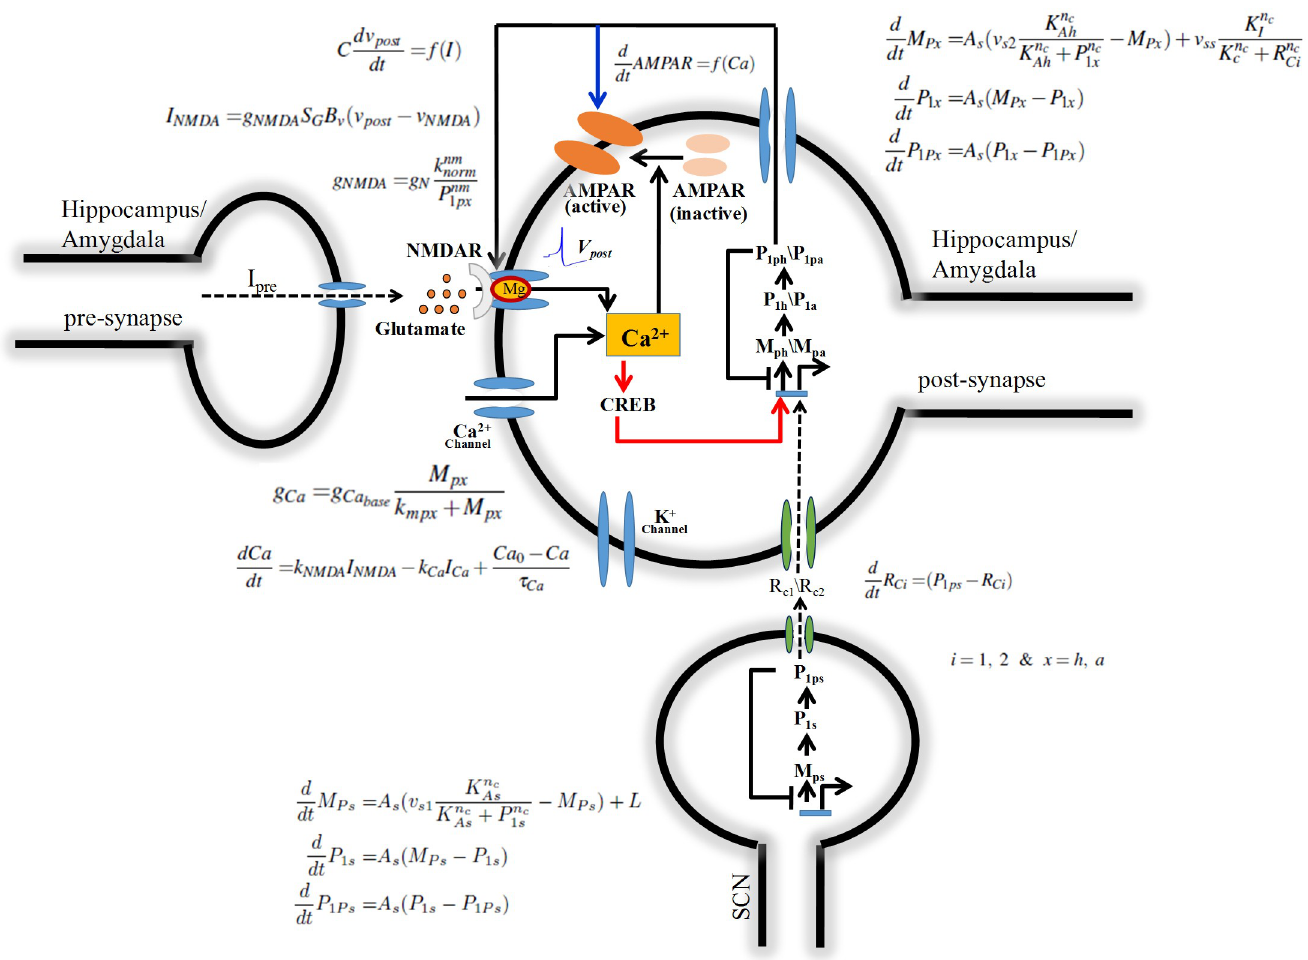
Fig 1. Multi-scale model for LTP/LTD, learning and memory. It is a unidirectionally coupled model with only SCN interacts hippocampus/amygdala and not vice- versa. Its a master-slave oscillator, with SCN acts as a master oscillator and hippocampus/amygdala as a slave oscillator. As mentioned earlier Goodwin type model is used to capture the SCN and hippocampus/amygdala circadian dynamics [53] which consists of 3 variables. These two Goodwin oscillators are coupled via an intermediate variable R / R . Hippocampus/amygdala model consists of pre and postsynaptic neurons. Due to presynaptic stimuli, glutamate is released and binds C 1 C 2 with NMDAR. These are permeable to calcium which is responsible for the insertion and removal of AMPAR. Conductance model of neurons are modified version of ML model. Rate equations and parameters are discuss in Materials and method section. Here red arrows indicate that the regulation is only present for the hippocampus model, while the blue arrows are only taken for amygdala.